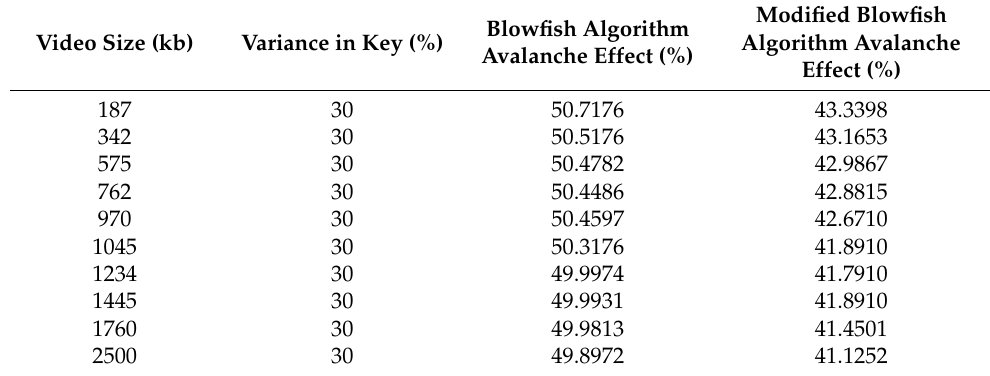
Table 3. Analysis of avalanche effect of Blowfish and modified Blowfish algorithms. Video Size (kb) Variance in Key (%)